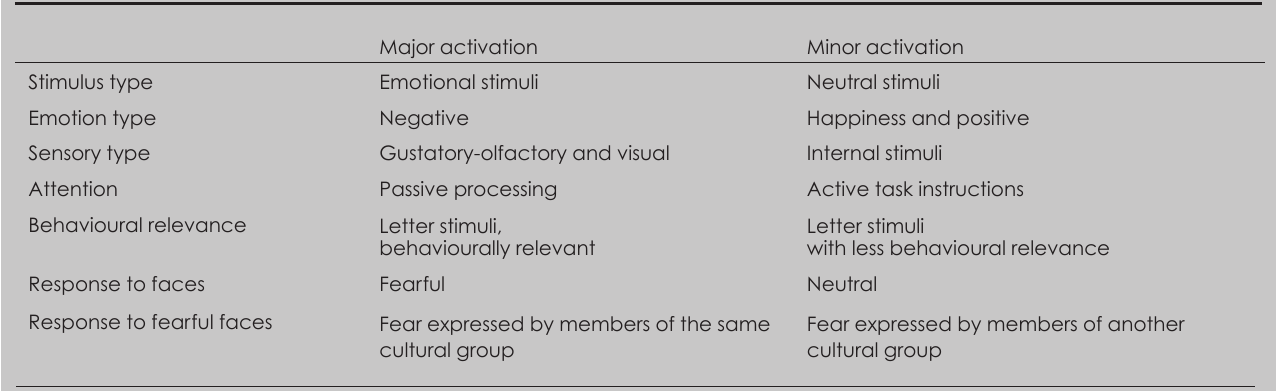
Table I. Amygdala activation in response to